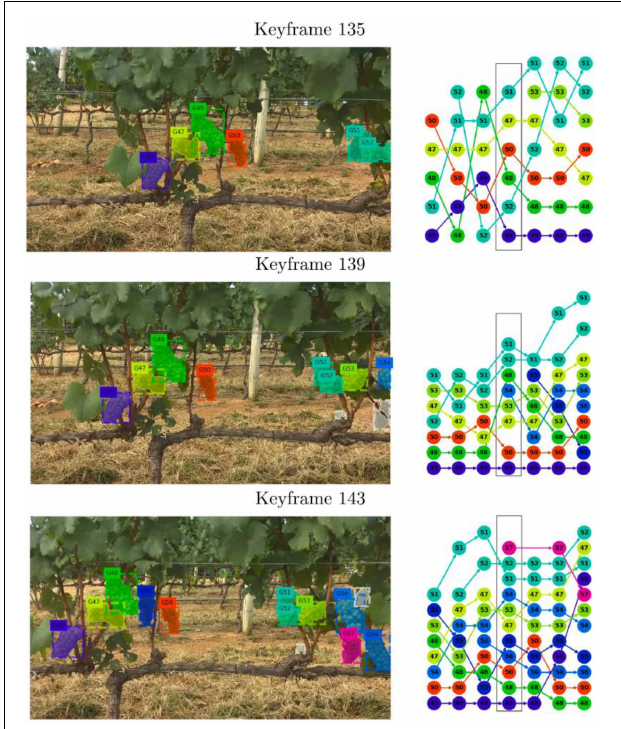
FIGURE 9 | Instance matching and tracking by 3-D assignment. (Left) Key frames extracted from a video sequence with a 1,080-p camera. (Right) Graph-based tracking. Each column represents instances found by a neural network, and each color represents an individual grape cluster in a video